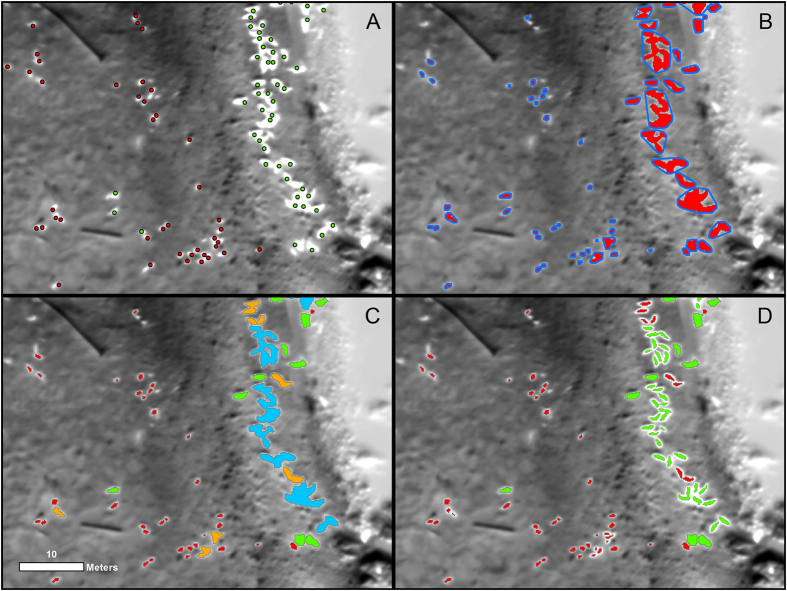
(A) Thermal imagery with overlaid human-identified seal points (red = YOY, green = adult). (B) Red seal polygons outlined by blue convex hulls. (C) Tier 1 model classification of seals. Blue polygons are adult aggregations, orange polygons are YOY aggregations, green polygons are individual adults and red polygons are individual YOYs. (D) Aggregation polygons after high pass filtering, broken up into individual adults and YOYs. This map was created with ArcMap GIS software (version 10.4.1, Esri Inc.).